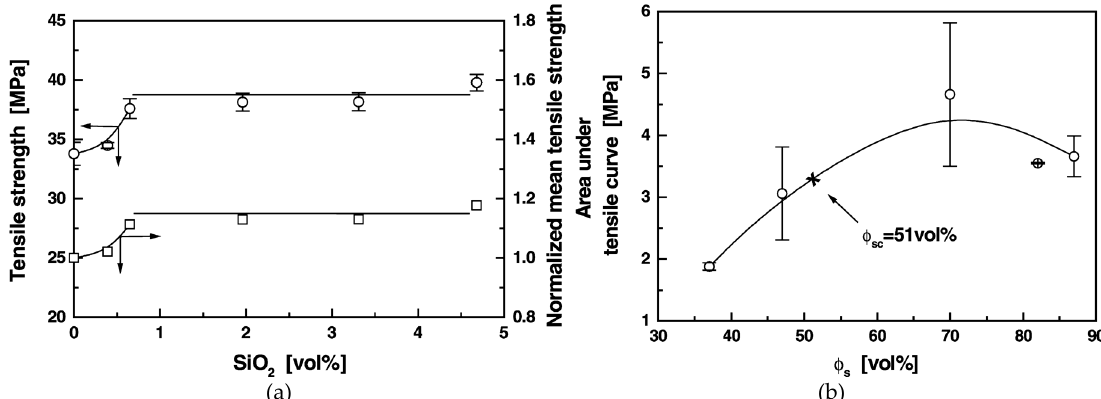
Figure 21. Tensile strength of SiO 2 -g-PS/PP composites as a function of the volume fraction of SiO 2 ( a ), and area under the tensile stress–strain curve of SiO 2 -g-PS/PP composites as a function of the stress volume fraction of φ s ( b ) [60].